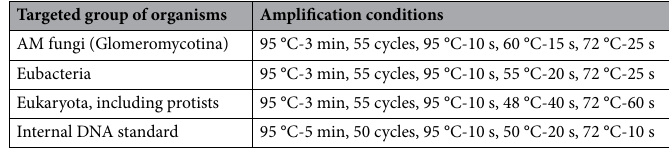
Table 3. Amplification conditions for the different groups of targeted